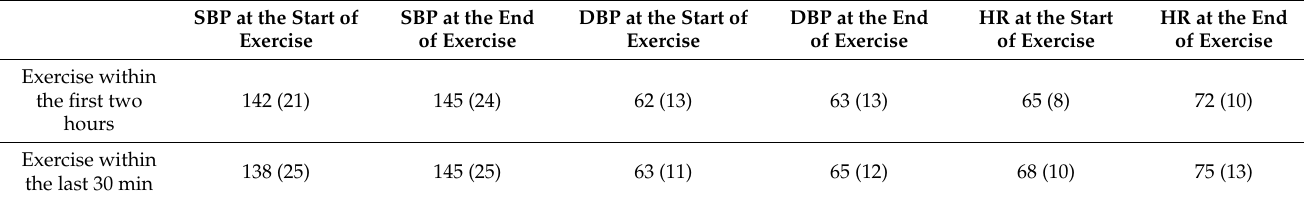
Table 3. Hemodynamic control during